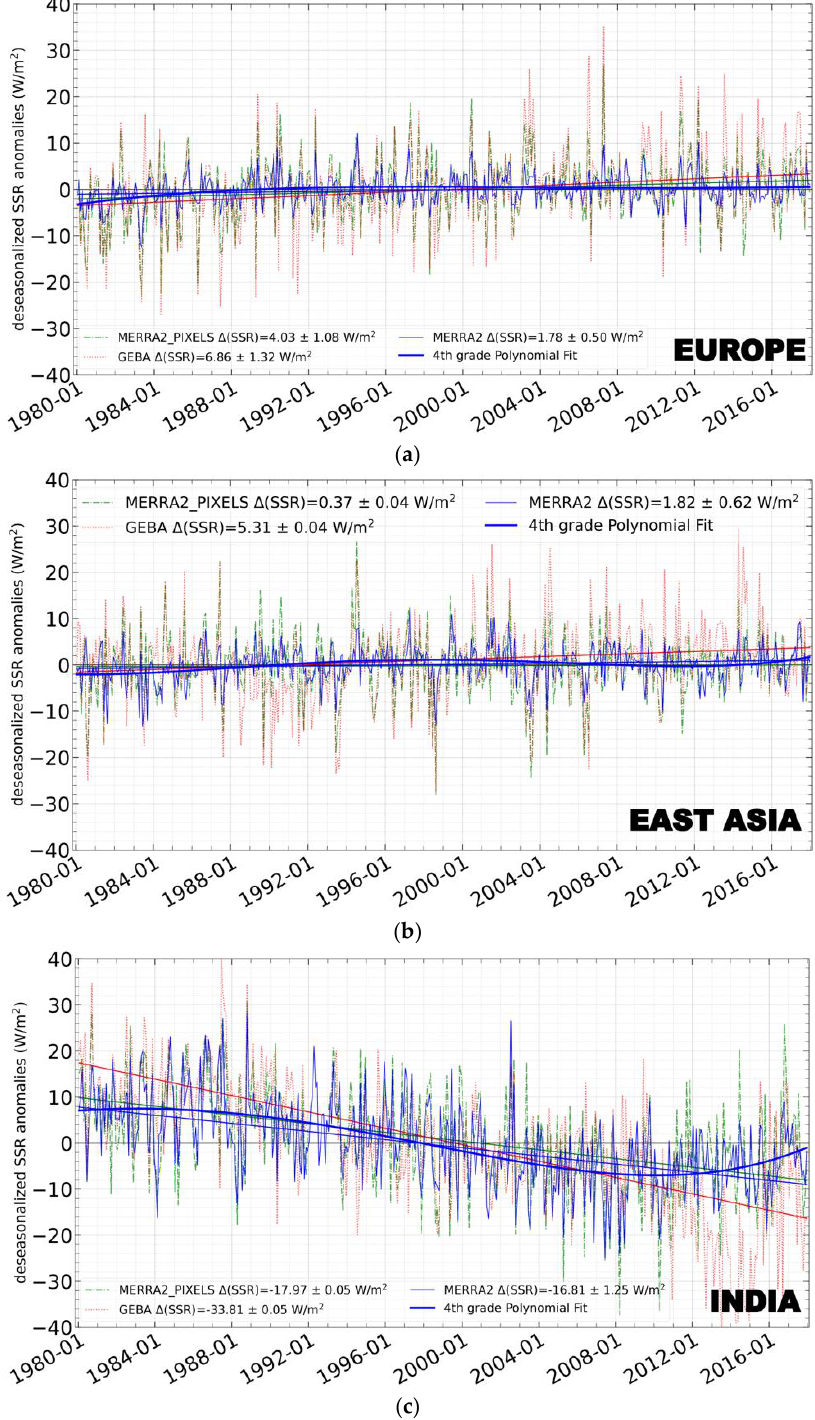
Figure 13. Timeseries (January 1980 – December 2017) of deseasonalized anomalies of SSR for three selected world areas with homogeneous trends (see red rectangles in Figure 11), namely, Europe ( a ), East Asia ( b ) and India ( c ). For every area, results are given based on GEBA stations (red dotted lines), corresponding MERRA-2 pixels (including the stations, green dot-dashed lines) and all MERRA-2 pixels of the areas (blue lines). Moreover, the linearly fitted lines to each timeseries are also displayed with similar colors, while blue line displaying the 4th-order polynomial fit applied to the time series of MERRA-2 SSR for the entire world areas are also shown.